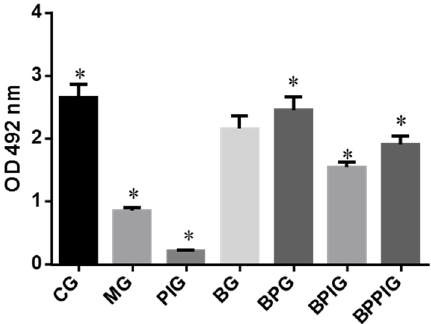
Figure 4. The activity of PPAR ‐α in different groups: The effects of BP on the antagonist of PPAR ‐α in different groups by using blood samples. Eight samples were analyzed in each group. All data are presented as mean value ± S.D. * p < 0.05 via a blueberry juice group BG.